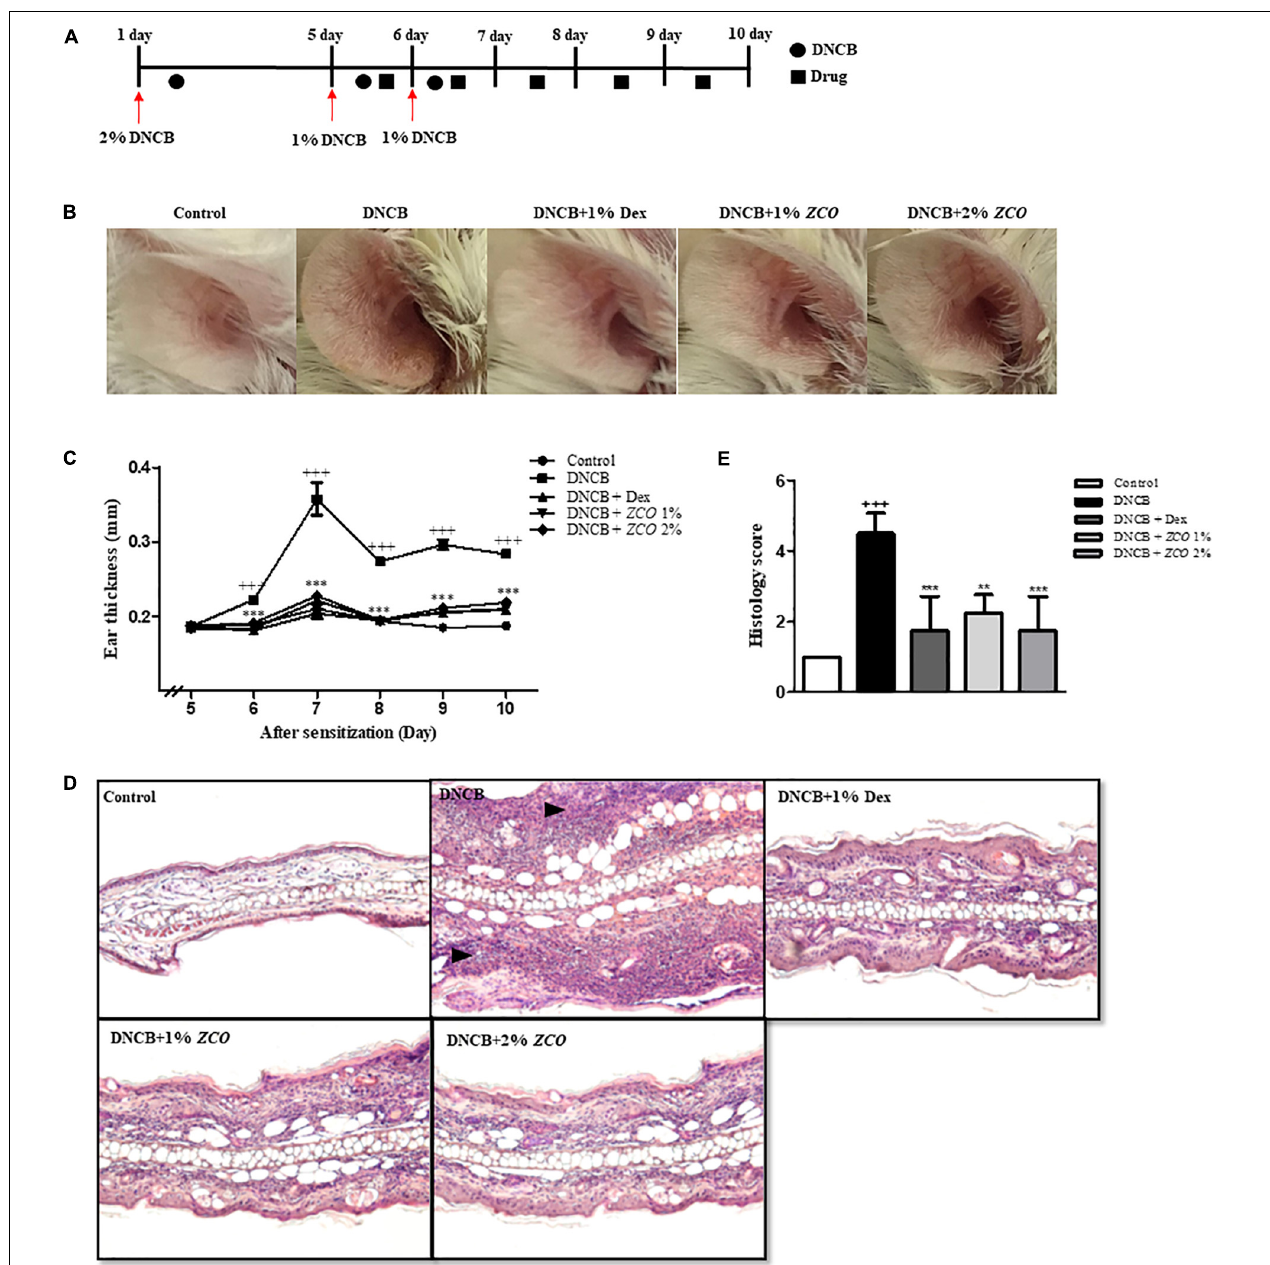
FIGURE 8 | Effect of ZCO on Atopic Dermatitis in Mice. (A) Experimental design for the induction of AD. 5 days after the first boost with 2% DNCB (150 µ L/mouse) to the abdomen, 1% DNCB was applied to both sides of the ears on day 6 and 7. Drug were pre-applied to the ear for 30 min. After 3 h, repeated one time. From day 8, drugs were applied only. (B) Representative photographed example of the effects of ZCO on DNCB-induced AD in the ear. (C) Ear thickness was daily measured with a digimatic micrometer. Data are presented as mean ± SEM ( ∗∗∗ P < 0.001 versus with DNCB group). (D) Histological analysis of AD mice. Representative photomicrographs of ear sections were stained with H&E staining (original magnification: × 100). (E) Histological changes (acanthosis, thickening of the subepidermal layer, cellular infiltration) were evaluated semiquantitatively on a grade of 1–5 (1 = no change from negative control group; 5 = maximum change). ∗∗ means that P < 0.01 versus with DNCB